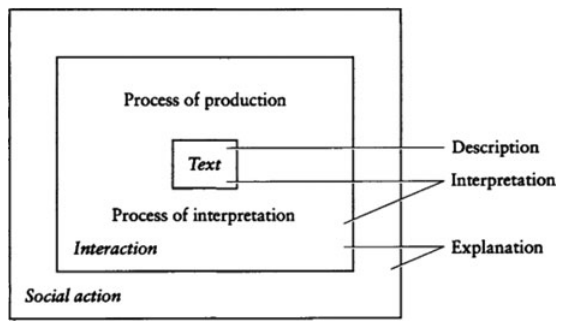
Fairclough’s three-dimensional framework for Critical Discourse Analysis. Taken from Fairclough